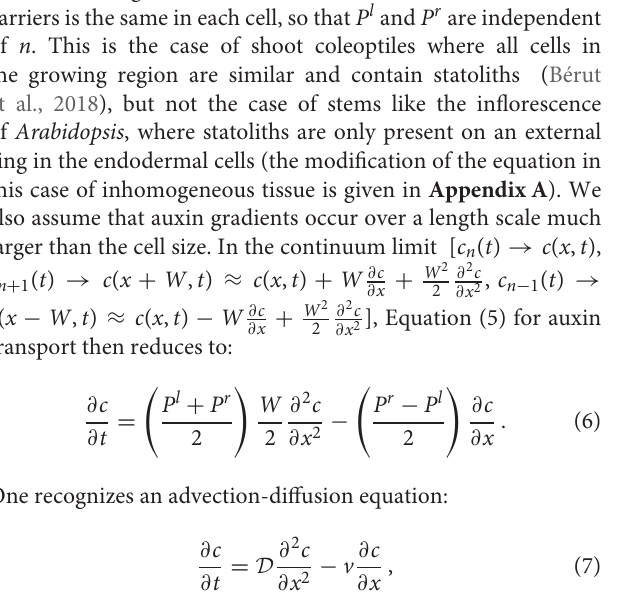
FIGURE 2 | One-dimensional, discrete model of auxin transport across the tissue (in reality w (PIN: red circle, ABCB: blue circle), whose distribution (and thus permeabilities P l , r n ) can be different on the right and left membrane of the cell. By contrast, influx of auxin (green dotted arrow) occurs with a symmetrical permeability P in on both side of the cell. An asymmetry of efflux permeabilities P l auxin across the tissue, yielding an auxin concentration gradient (background color gradient).